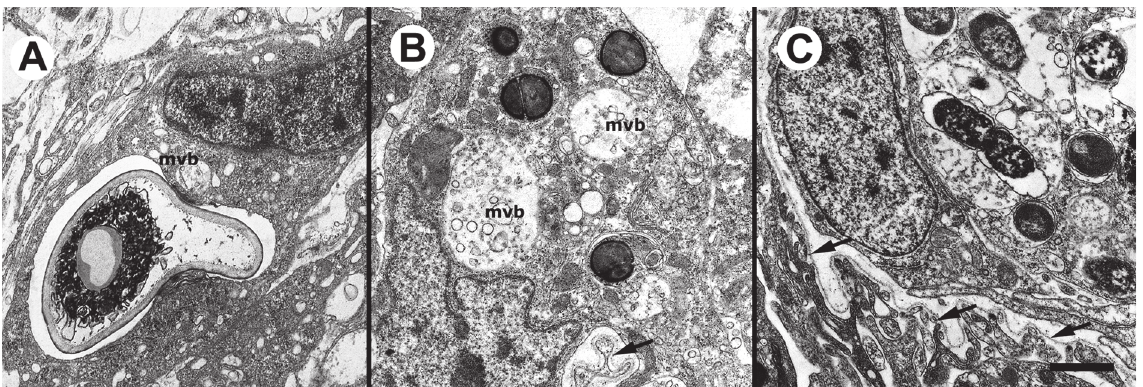
Fig 10. In vivo microbial phagocytosis by renal hemocytes (TEM). (A) Partly digested yeast cell engulfed by a phagocytic hyalinocyte; a small multivesicular body is seen close to the phagosome; (B) Several S . aureus cells engulfed by a hyalinocyte within individual phagosomes; multivesicular bodies of different sizes are also seen; arrow indicates a basal interdigitation of a renal epithelial cell, surrounded by the basal membrane (arrow); (C) E . coli cells in different stages of digestion are contained within complex phagosomes; the basal membrane of the renal epithelium is indicated by arrows. Abbreviation: mvb , multivesicular body. Scale bar represents 1 μ